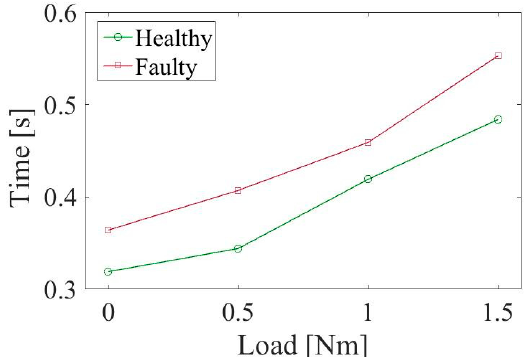
Figure 15. Comparison of the experimental result of starting time under different loads, based on the mean value of 40 samples for each load.